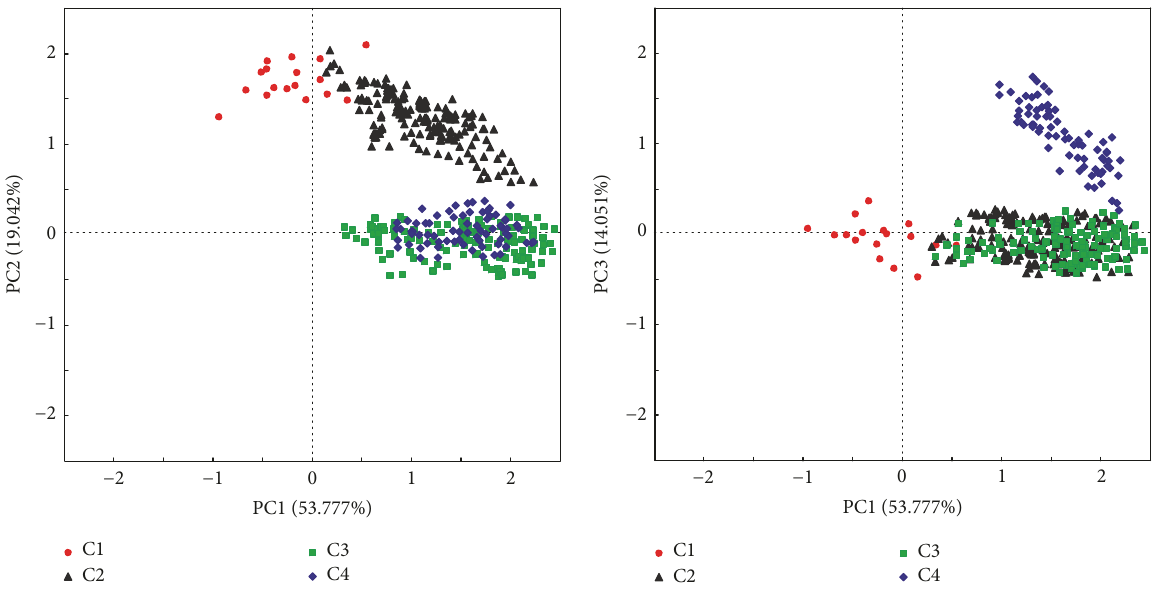
Figure 9: Plot of principal component scores for the first three components for the water samples labeled with the groundwater